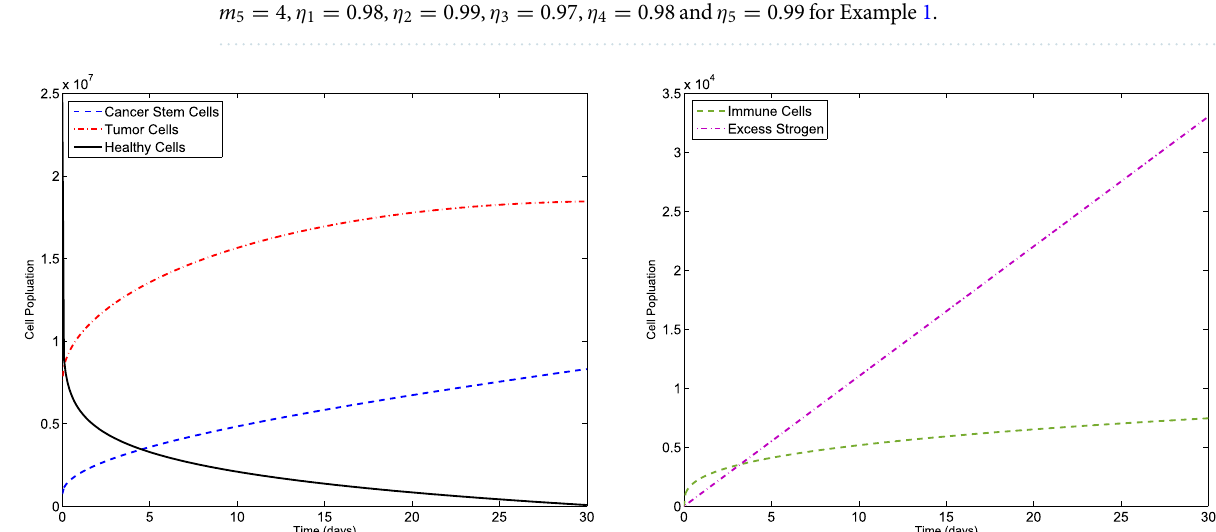
Figure 3. Evolution of { C ( t ) , T ( t ) , H ( t ) , I ( t ) , E ( t ) } vs time for the F-BCCM with m 1 = 3 , m 2 = m 3 = m 4 = 4 and m 5 = 5 , η 1 = 0.10 , η 2 = 0.15 , η 3 = 0.20 , η 4 = 0.25 and η 5 = 0.30 for Example